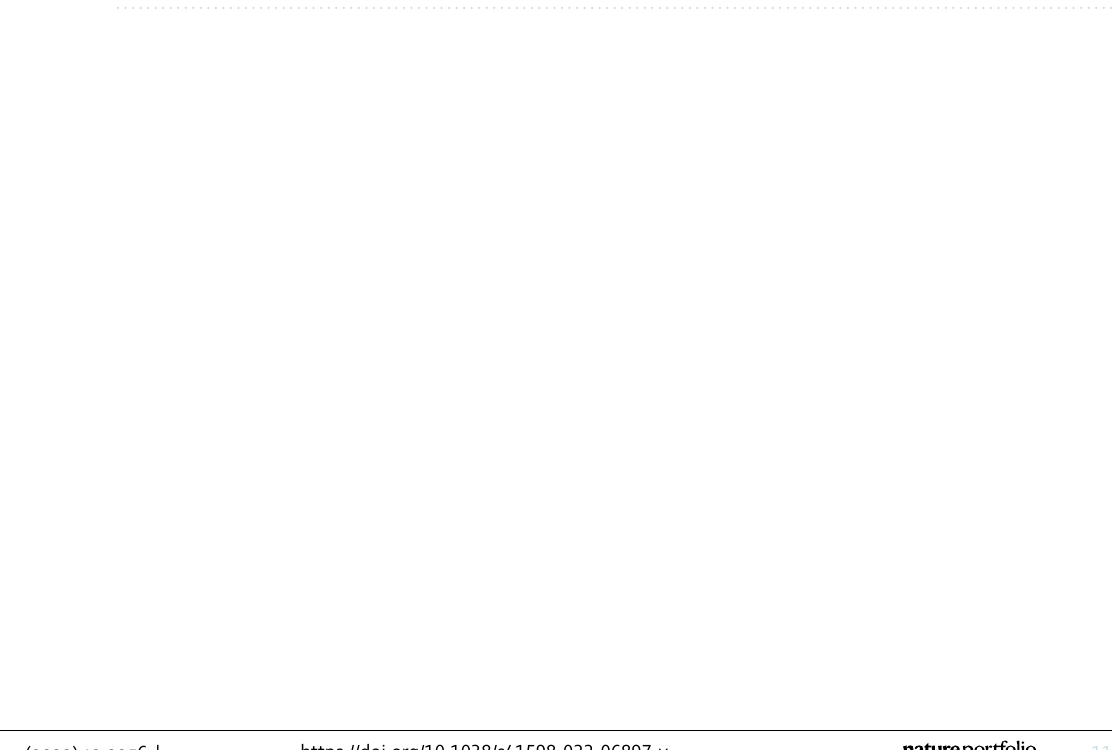
Figure 7. Impact of β on velocity distribution when t = 1 , Gr = 1.5 , Gm = 1.5 , Pr = 20 , Sc = 20 , and (cid:31) = 1